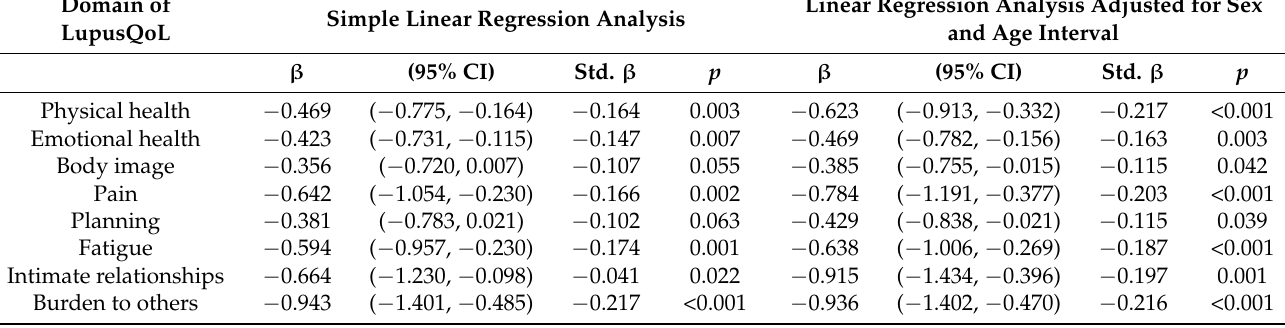
Table 4. Linear regression analyses of the eight domains of Lupus Quality of Life (LupusQoL) with the Systemic Lupus Erythematosus Disease Activity Score (SLE-DAS) in patients with systemic lupus erythematosus. Domain of